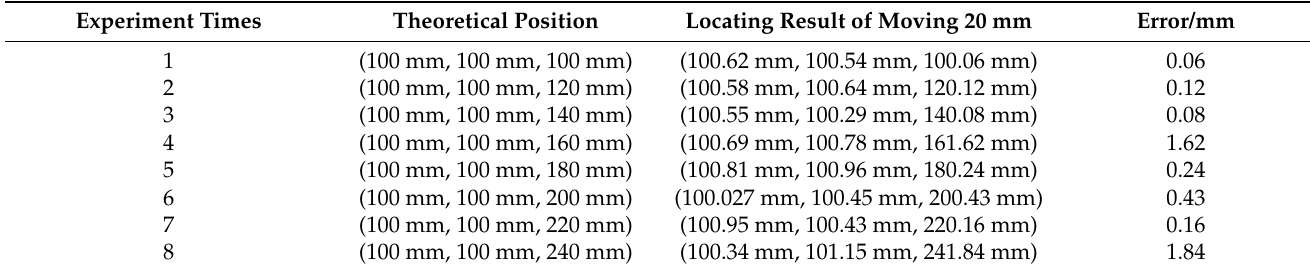
Table 4. 3D locating of chili fruits.